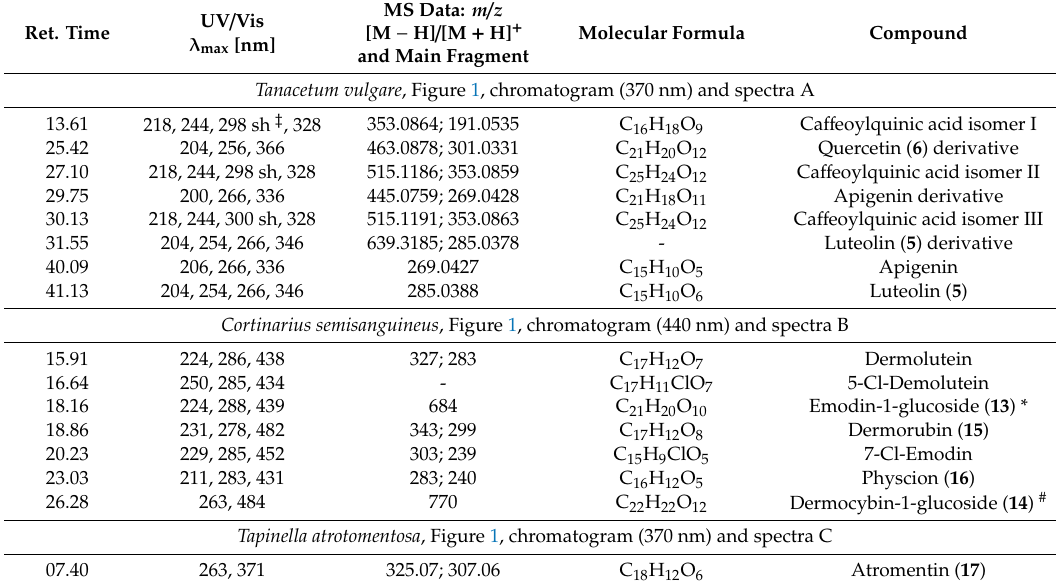
Table 3. The results of the HPLC-UV / Vis-MS data of Tanacetum vulgare , Cortinarius semisanguineus and Tapinella atrotomentosa . The chemical structures and the calculated MS of the numbered compounds are found in Table 2. The MS data for C. semisanguineus refers to our earlier data published in [68] and [85]. Ret.